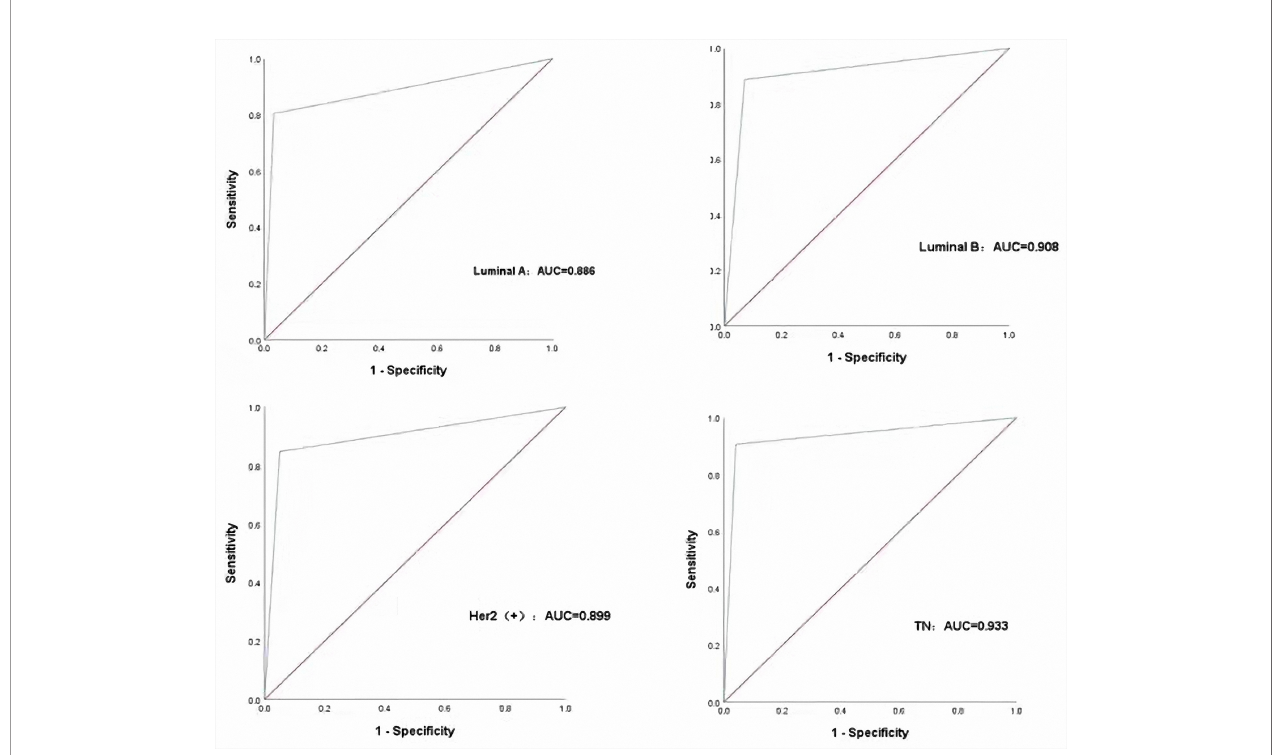
FIGURE 4 | Performance of the CAD in classifying different molecular subtypes with the four subtypes.